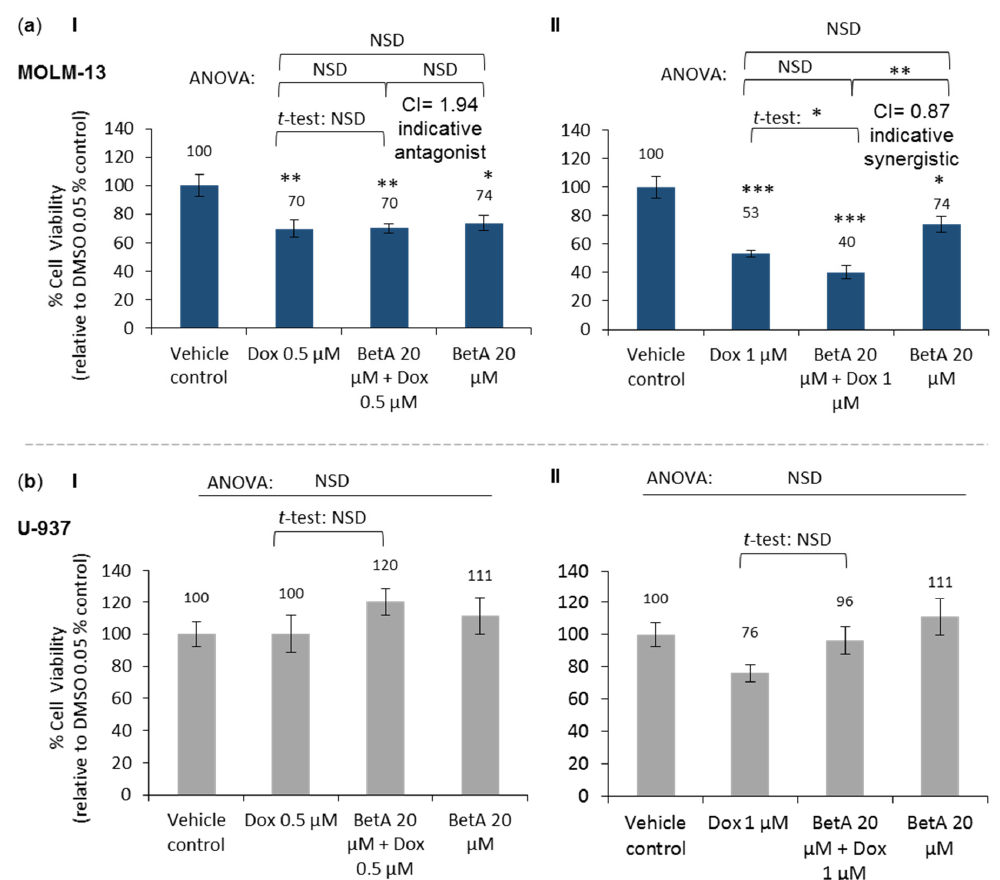
Figure 1. Effect on cell viability of betulinic acid and doxorubicin combination treatments on leukaemic MOLM-13 and U-937 cells MOLM-13 ( a ) and U-937 ( b ) cells were treated for 24 h by Dox 0.5 µ M with BetA 20 µ M ( I ) and Dox 1 µ M with BetA 20 μ M ( II ), and the respective individual drugs. The data were expressed as mean ± SE of percentage relative to values obtained for control cells (cells with DMOS 0.05% vehicle). Cell viability was determined by fluorescence using CyQuant Direct assay. The data set was analysed by one-way ANOVA with Tukey post-hoc test. Single Dox and combination drugs were compared by two samples t -test. n = 4. Statistical difference was accepted as following: p > 0.05 no significant difference (NSD), * p ≤ 0.05 significant, ** p ≤ 0.01 highly significant, *** p ≤ 0.001 very highly significant. Synergy quantification was based on Chou–Talaya method by combination index (CI) using CompuSyn (non-constant ratio design). Additive effect (CI = 1), synergism (CI < 1), antagonism (CI >